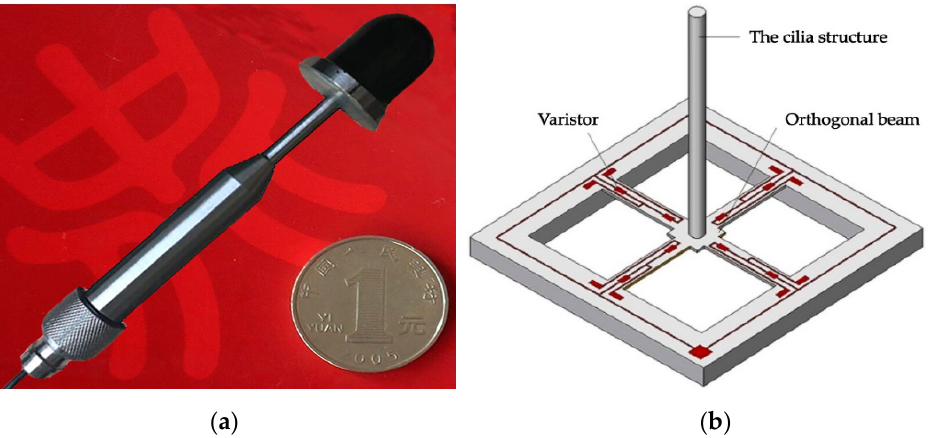
Figure 16. ( a ) MEMS vector hydrophone and ( b ) Cross-beam structure.